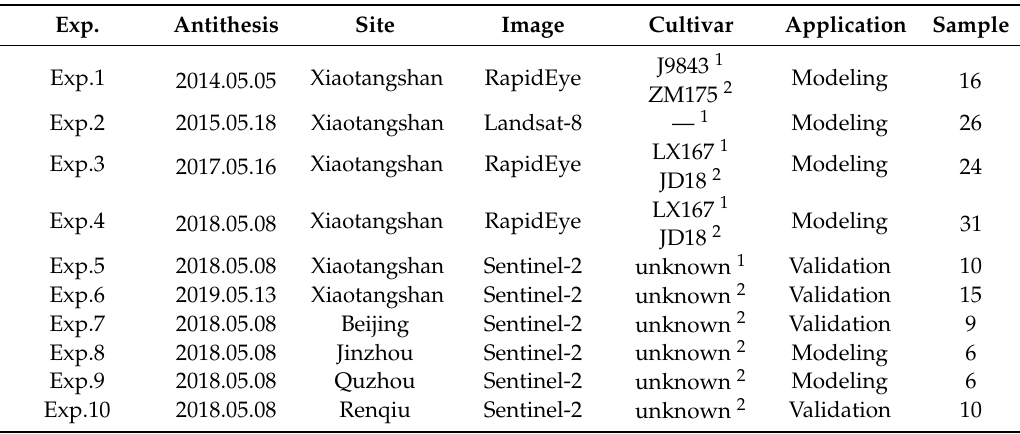
Table 1. Summary of the experiment (Exp.) in this